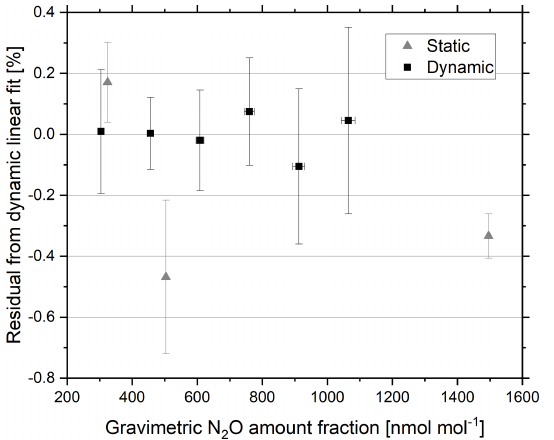
Figure 8. Certified NPL amount fraction minus the certified Empa amount fraction of five N 2 O reference materials in the range 290– 370nmolmol − 1 (crosses). Error bars represent the extended com- bined standard uncertainty ( k = 2) for NPL certified amount frac- tion. The Empa certified amount fraction is marked by a solid line at y = 0, and dashed lines represent the Empa measurement uncer-